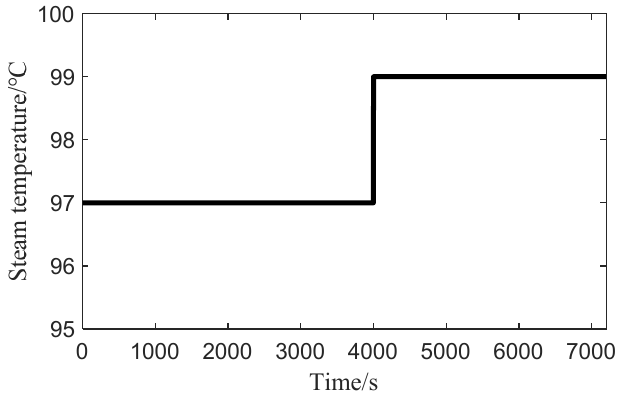
Figure 27. Disturbance of the T steam increase.